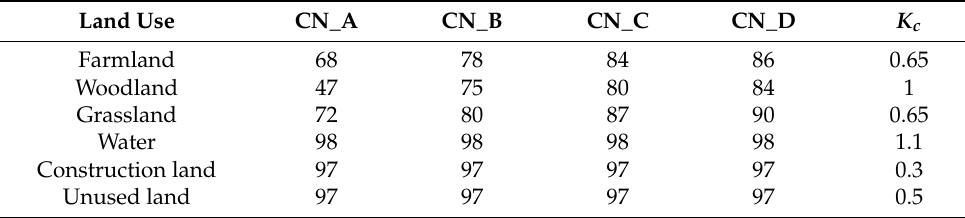
Table 3. Model Input Parameter